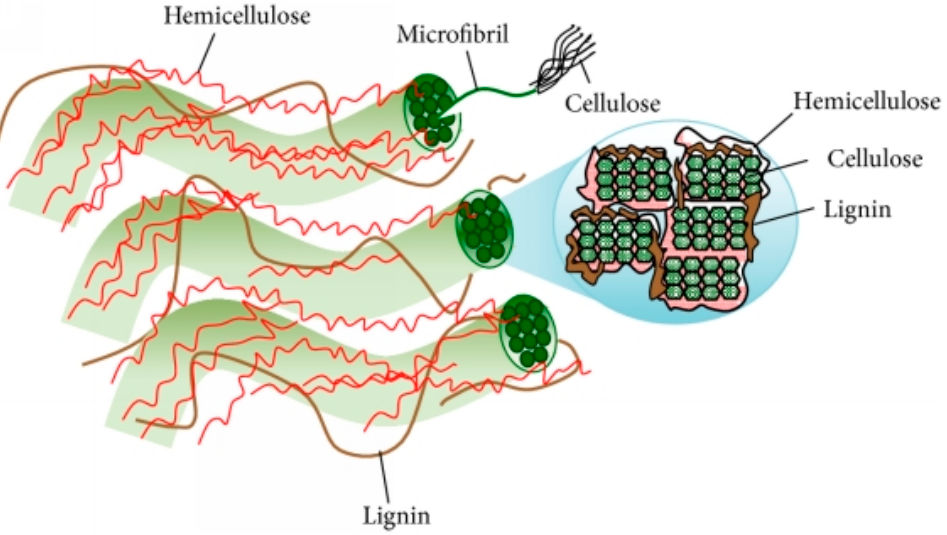
Figure 1. The three main components of a plant cell wall (reprint from [15]).